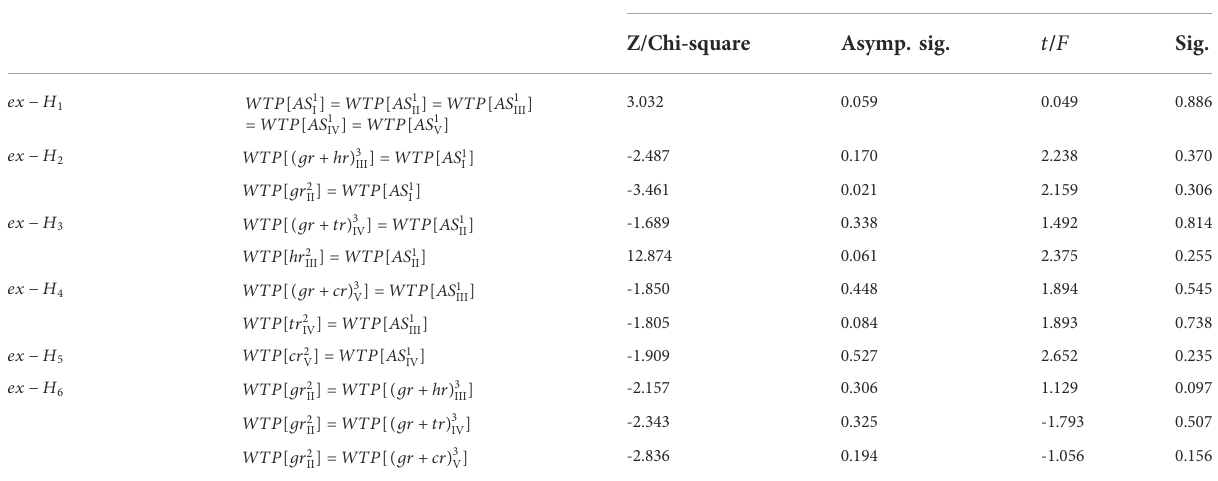
TABLE 9 Results of external scope tests. Hypothesis